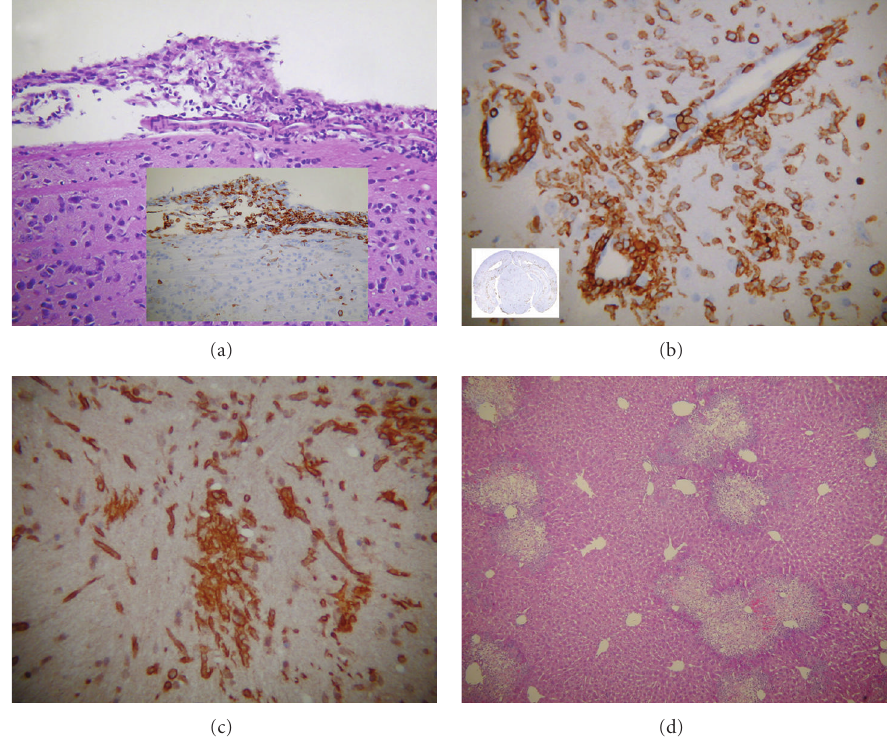
Figure 2: Archetypical histopathology of brain and liver during acute infection with neurotropic strain. MHV-A59: serial coronal sections from MHV-A59-infected mice at day 5 post infection were stained with H & E or immunostained for CD45 (LCA: leukocyte common antigen, marker for inflammatory cells) or microglia/macrophage marker CD11b (OX42). (a) H & E staining shows acute meningitis and inset shows the presence of inflammatory cells positive for LCA. (b) Coronal sections stained for LCA show acute encephalitis in brain section characterized by the formation of perivascular cu ffi ng in high magnification. Inset shows presence of inflammatory infiltrates throughout the parenchyma. (c) The majority of LCA-positive inflammatory cells are stained positive for the macrophage/microglia marker CD11b in MHV-A59-infected brain parenchyma. (d) Liver pathology from the same infected mouse stained with H & E shows lesions throughout the liver